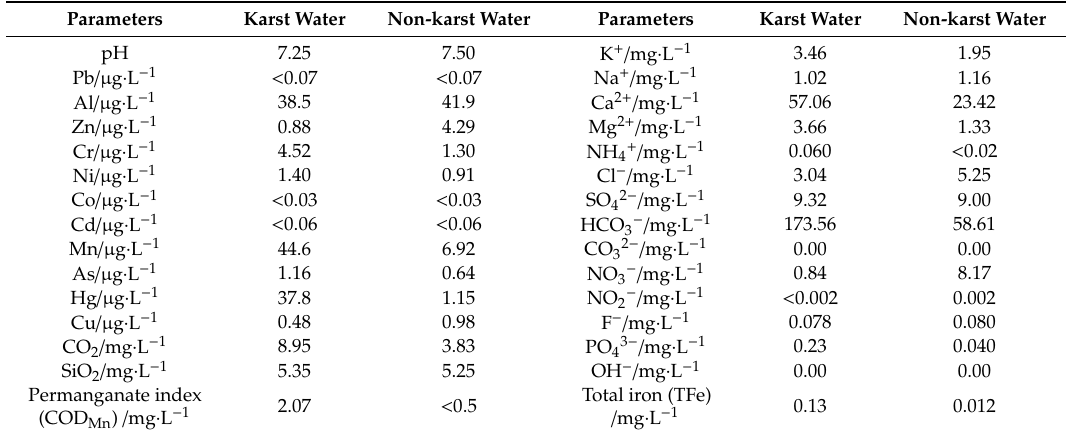
Table 1. Hydrochemical parameters of karst water and non-karst water used in the experiments. Parameters